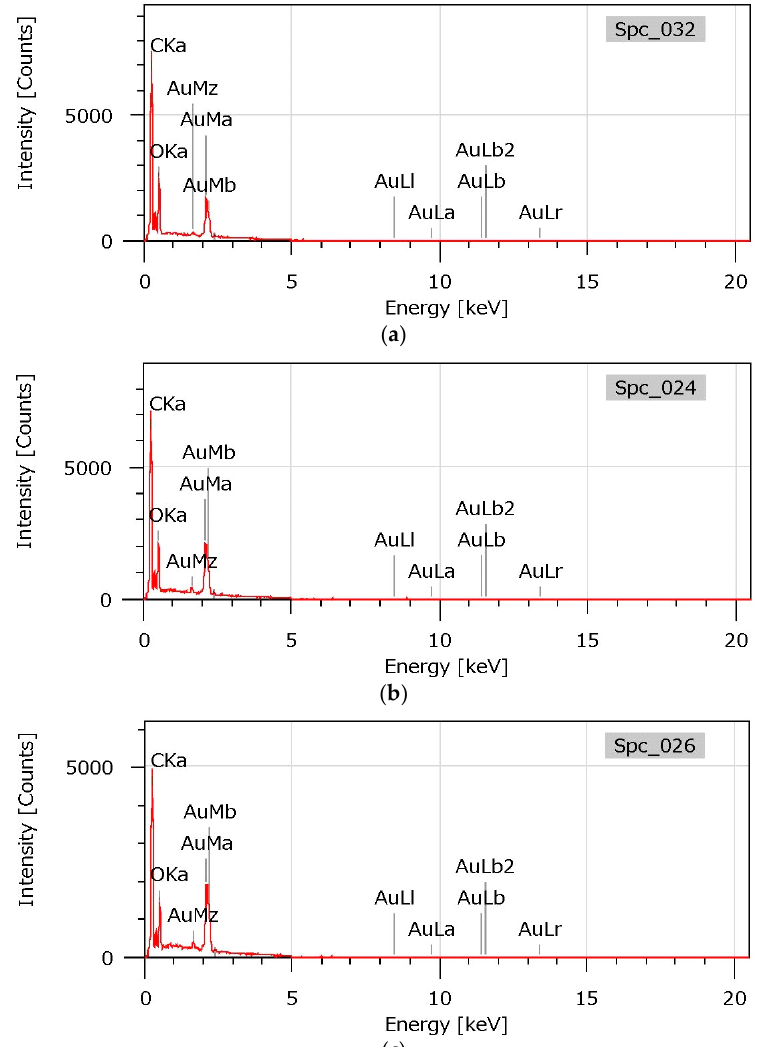
Figure 7. Comparison of D. gallinae body surfaces. ( a ) Control. ( b ) High-voltage impulse. ( c ) Heat. The color of the body surface is altered compared to the mites killed through starvation. Heat and high-voltage mite-control methods caused very similar changes in the coloration of the body sur- face.